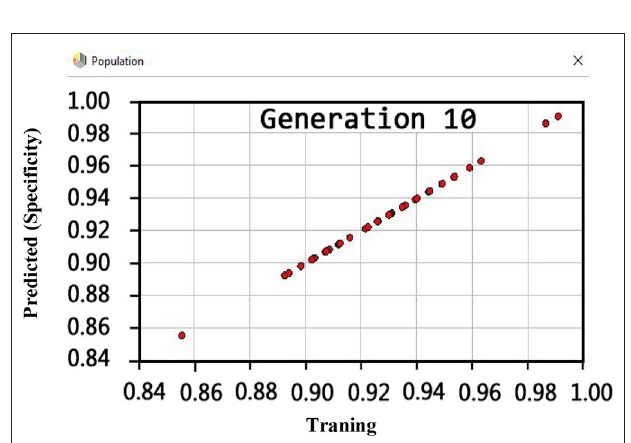
FIGURE 8 | Specificity diagram for GSVNA method for generation 10.